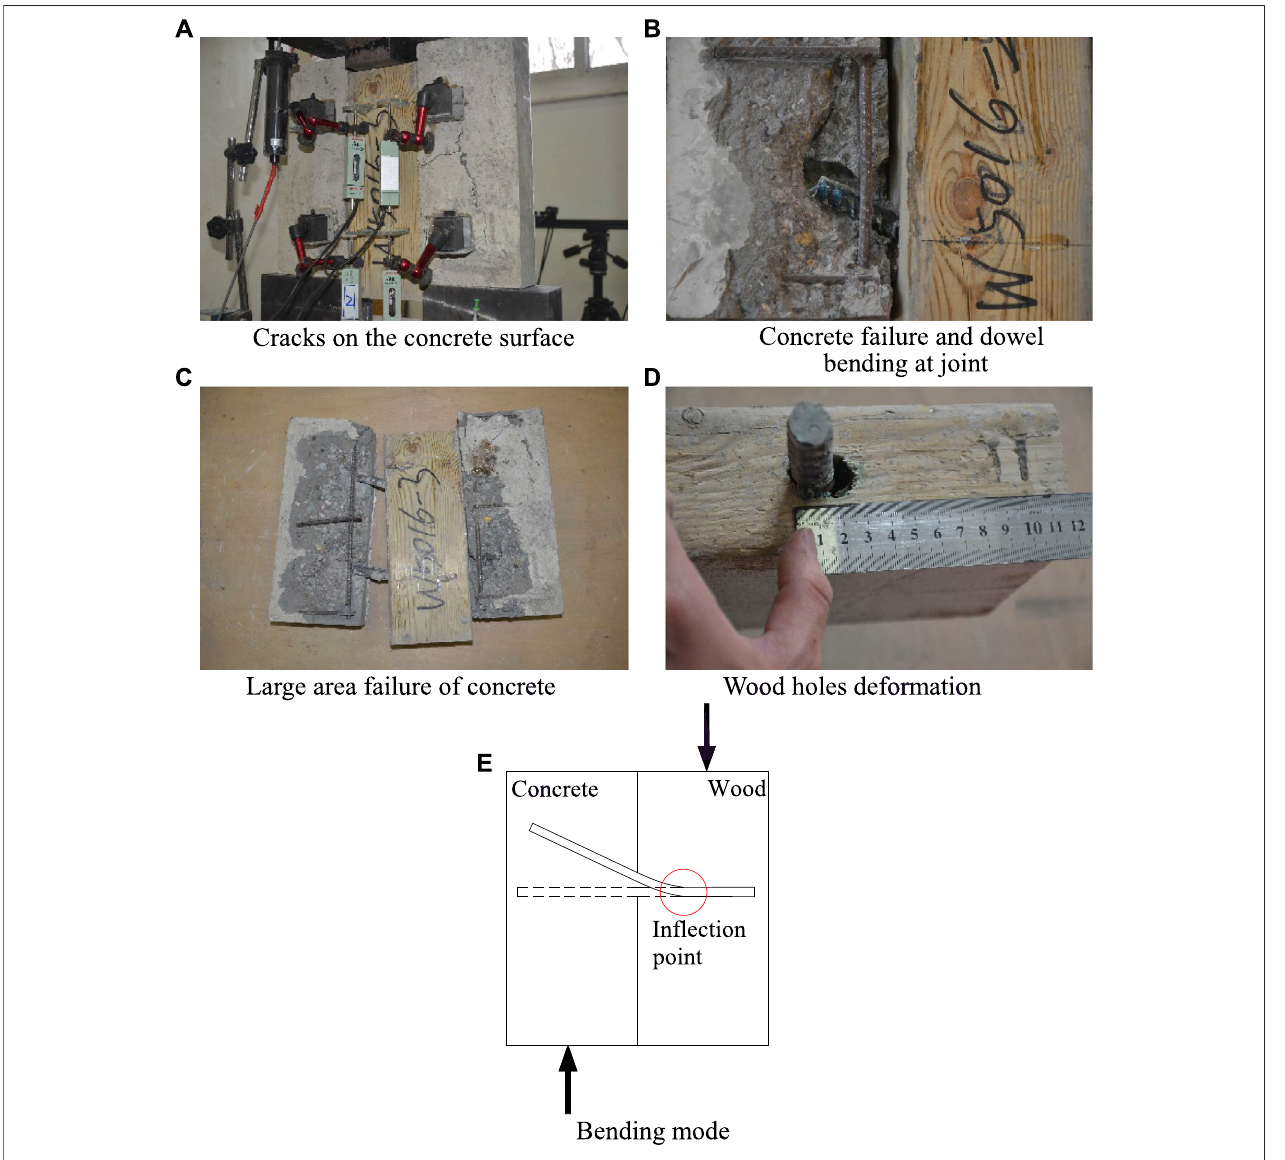
FIGURE7| Typicalfailure mode ofwood-concreteconnection. (A) Cracks onthe concrete surface. (B) Concrete failure and dowelbendingat joint. (C) Large area failure of concrete. (D) Wood holes deformation. (E) Bending mode.